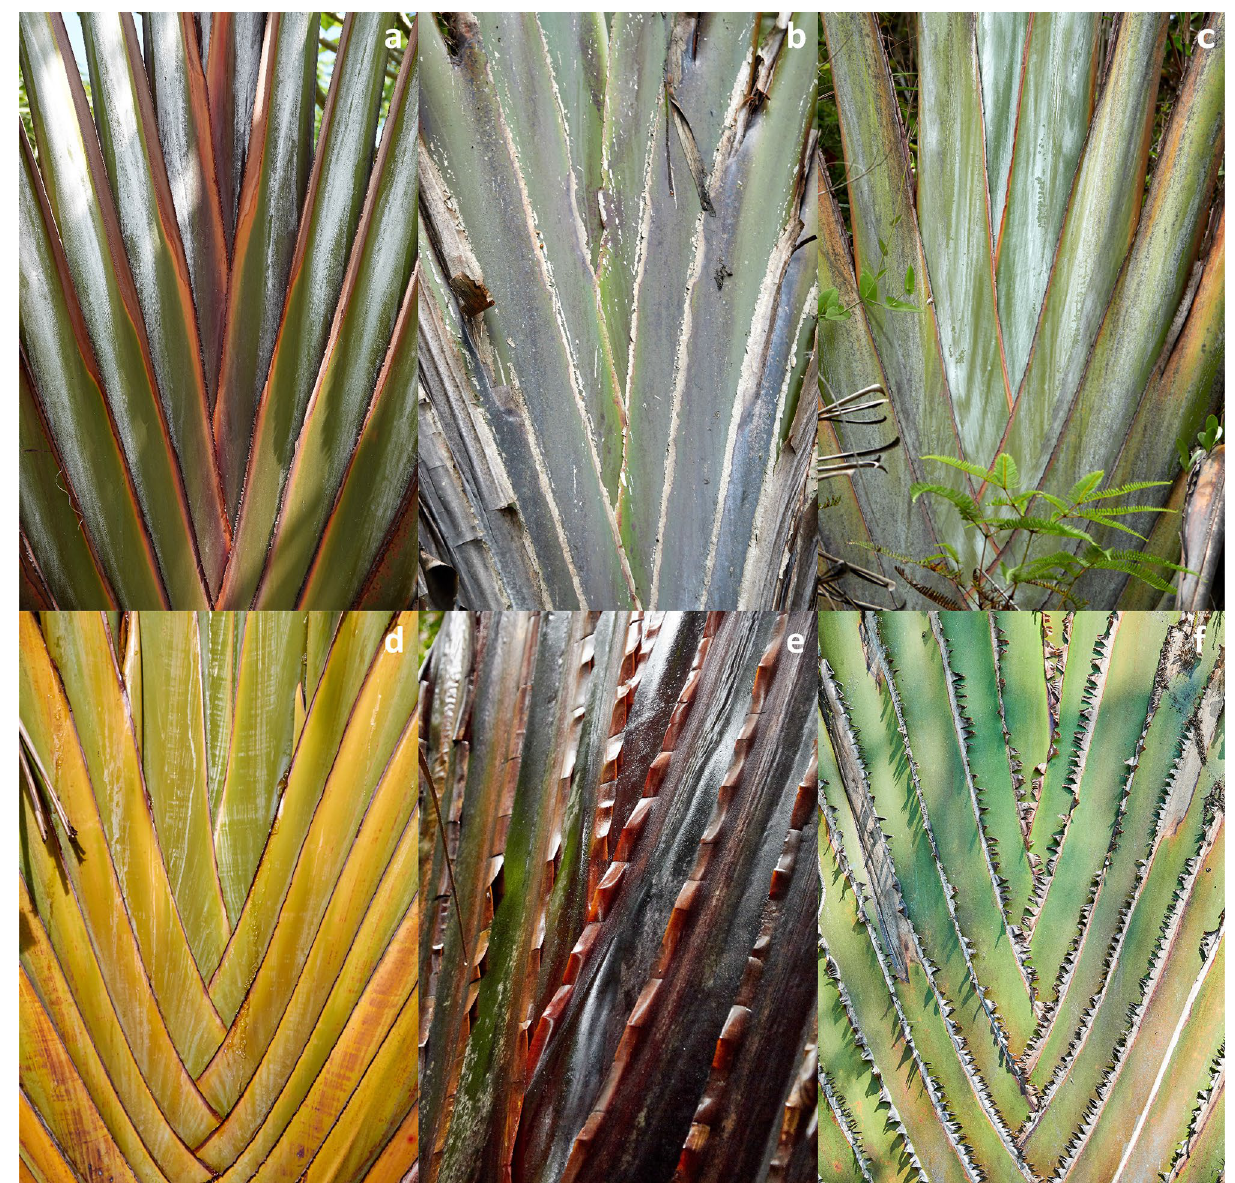
Figure 3. Comparison of petiole bases. ( a ) R. agatheae . ( b ) R. blancii . ( c ) R. grandis . ( d ) R. madagascariensis . ( e ) R. menahirana . ( f ) R. hladikorum . Photographs Thomas